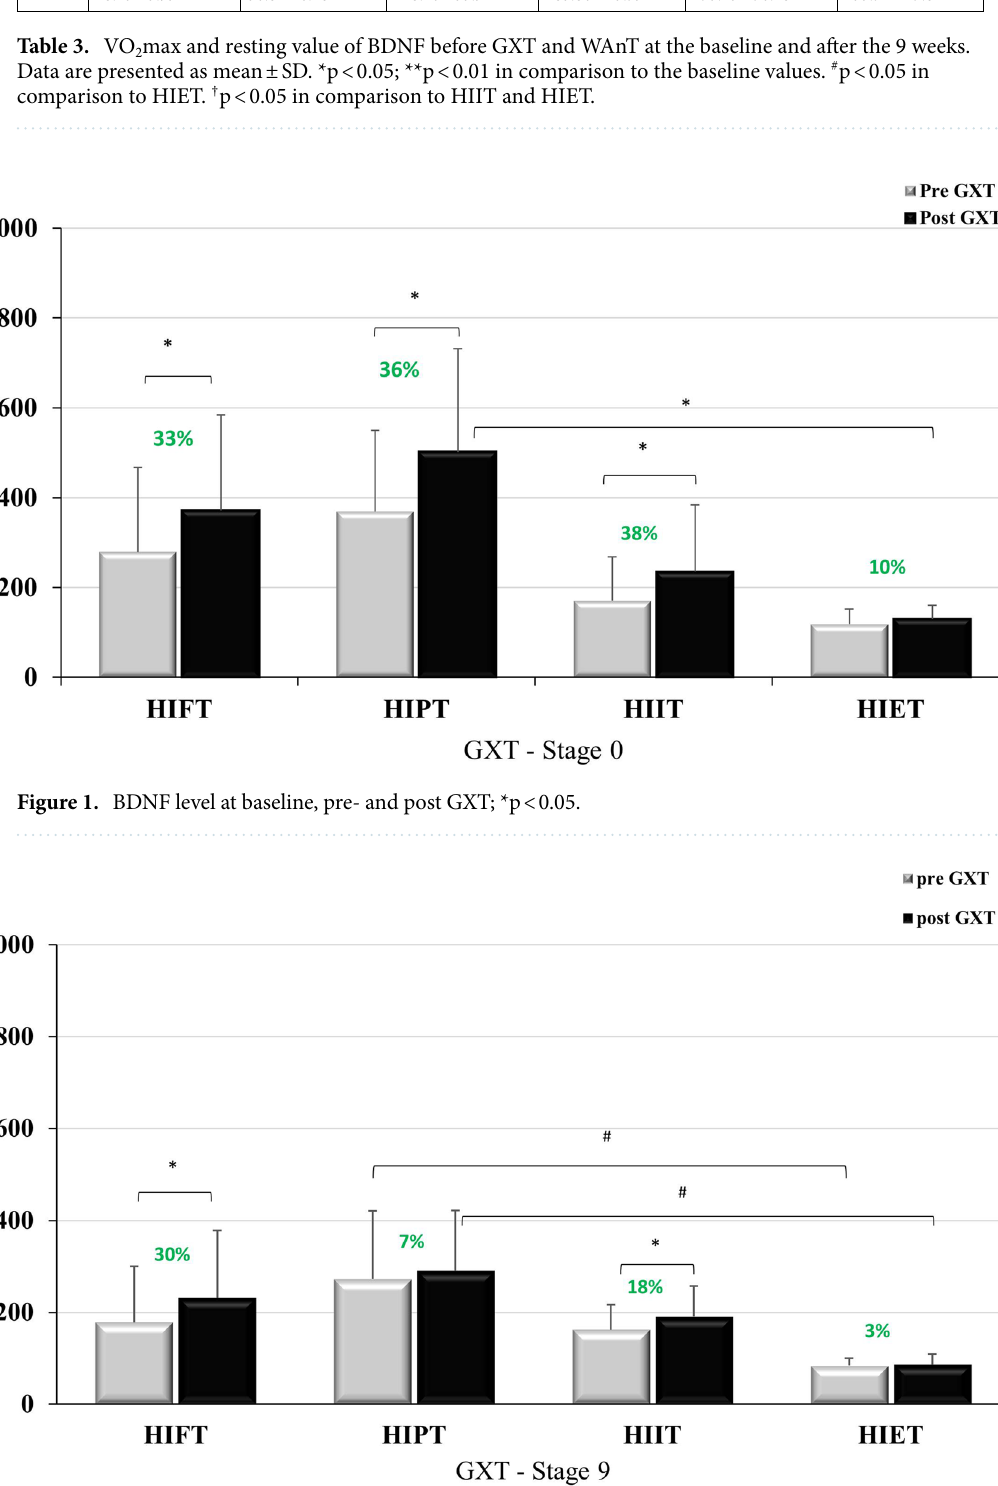
Figure 2. BDNF level after nine weeks training, pre- and post GXT; # p < 0.01; *p <